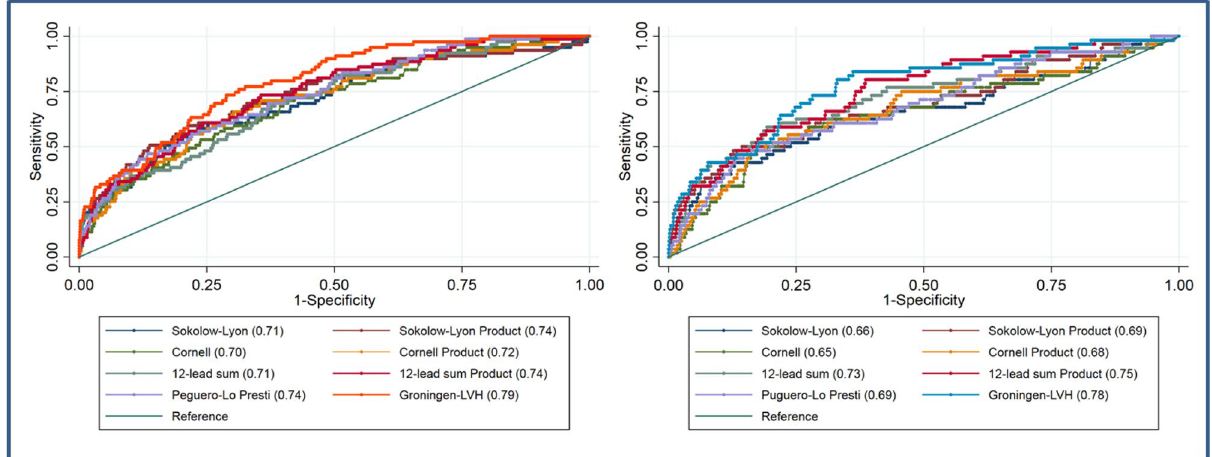
Figure 4. ROC curves for the existing and new developed ECG-LVH criteria in the training cohort. The different colors are ROC curves for each individual ECH-LVH criteria. The left graph shows the ROC curves in women and the right graph the ROC curves in men. The AUC of the Groningen-LVH criteria showed the largest AUC for both men and women. In parentheses the AUC is displayed. LVH left ventricular hypertrophy.